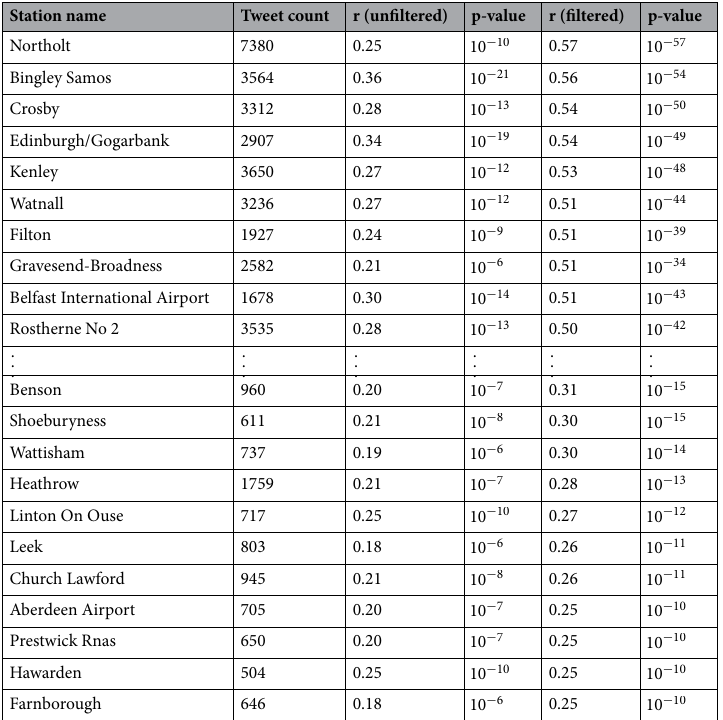
Table 4. Correlation between tweet volume and local wind speeds at a selection of UK weather stations. Data shown: Pearson’s correlation coefficient, r , for relationship between daily tweet counts and mean wind speeds for all tweets. Data are given for both unfiltered (average-wind or high-wind) and filtered (high-wind) tweets. Top-10 (strongest correlation) and bottom-10 (weakest correlation) stations are